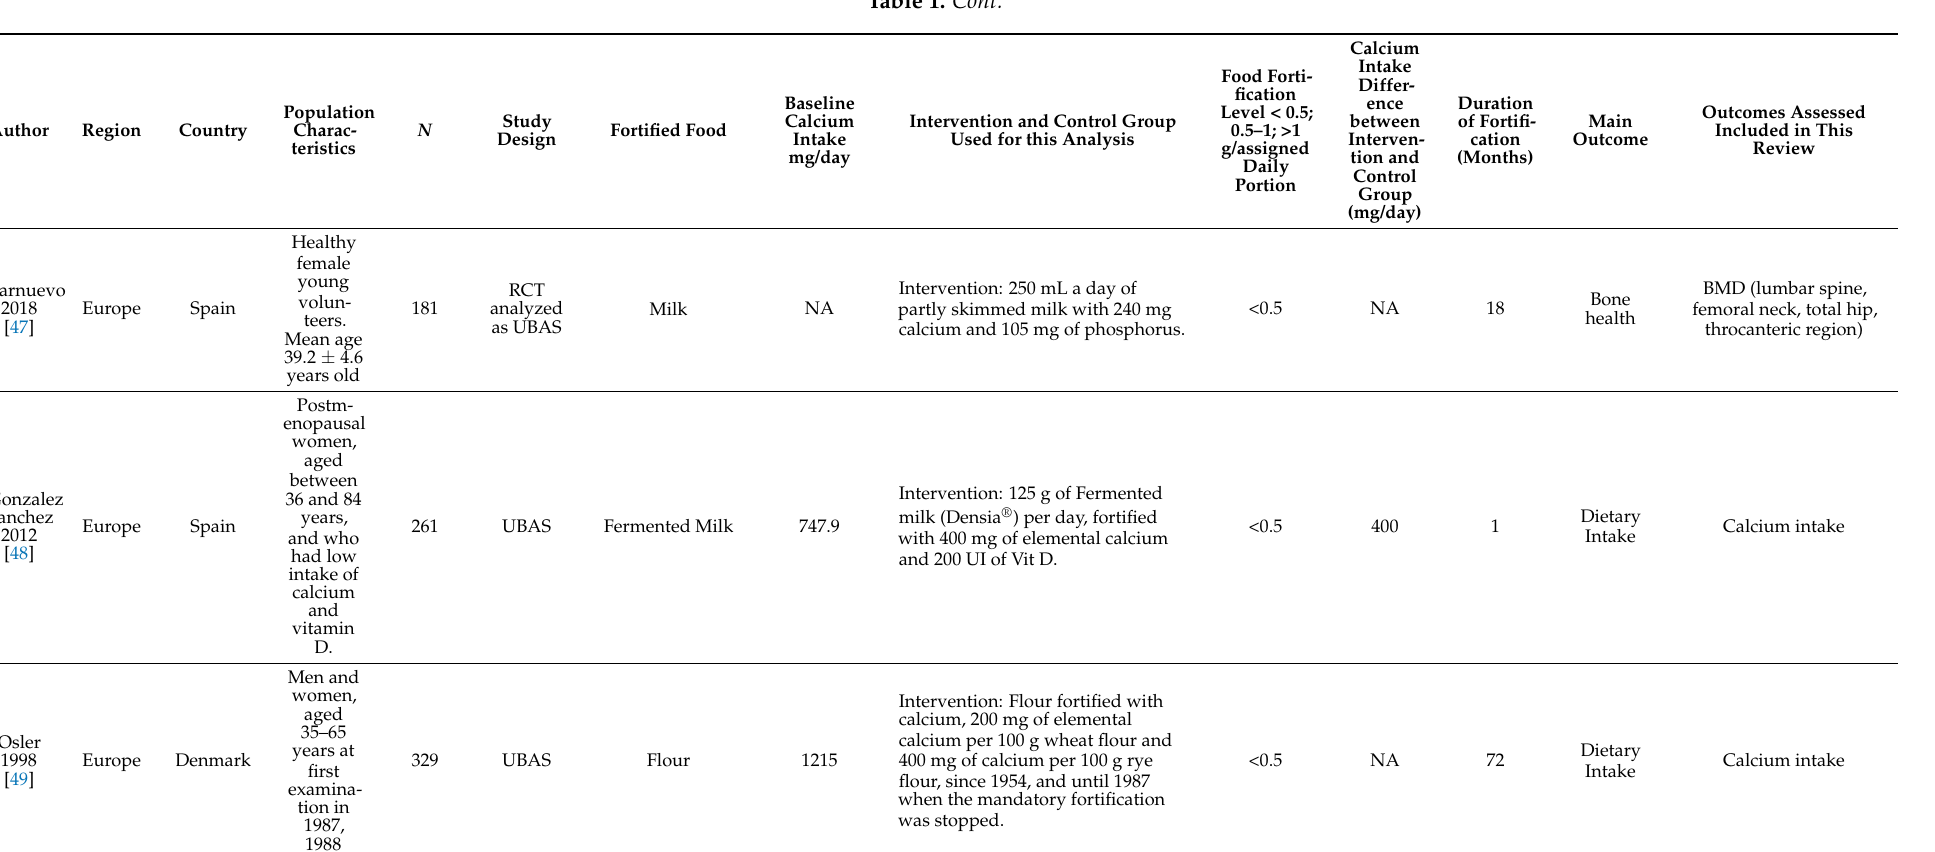
Intervention: Flour fortified with calcium, 200 mg of elemental calcium per 100 g wheat flour and 400 mg of calcium per 100 g rye flour, since 1954, and until 1987 when the mandatory fortification was